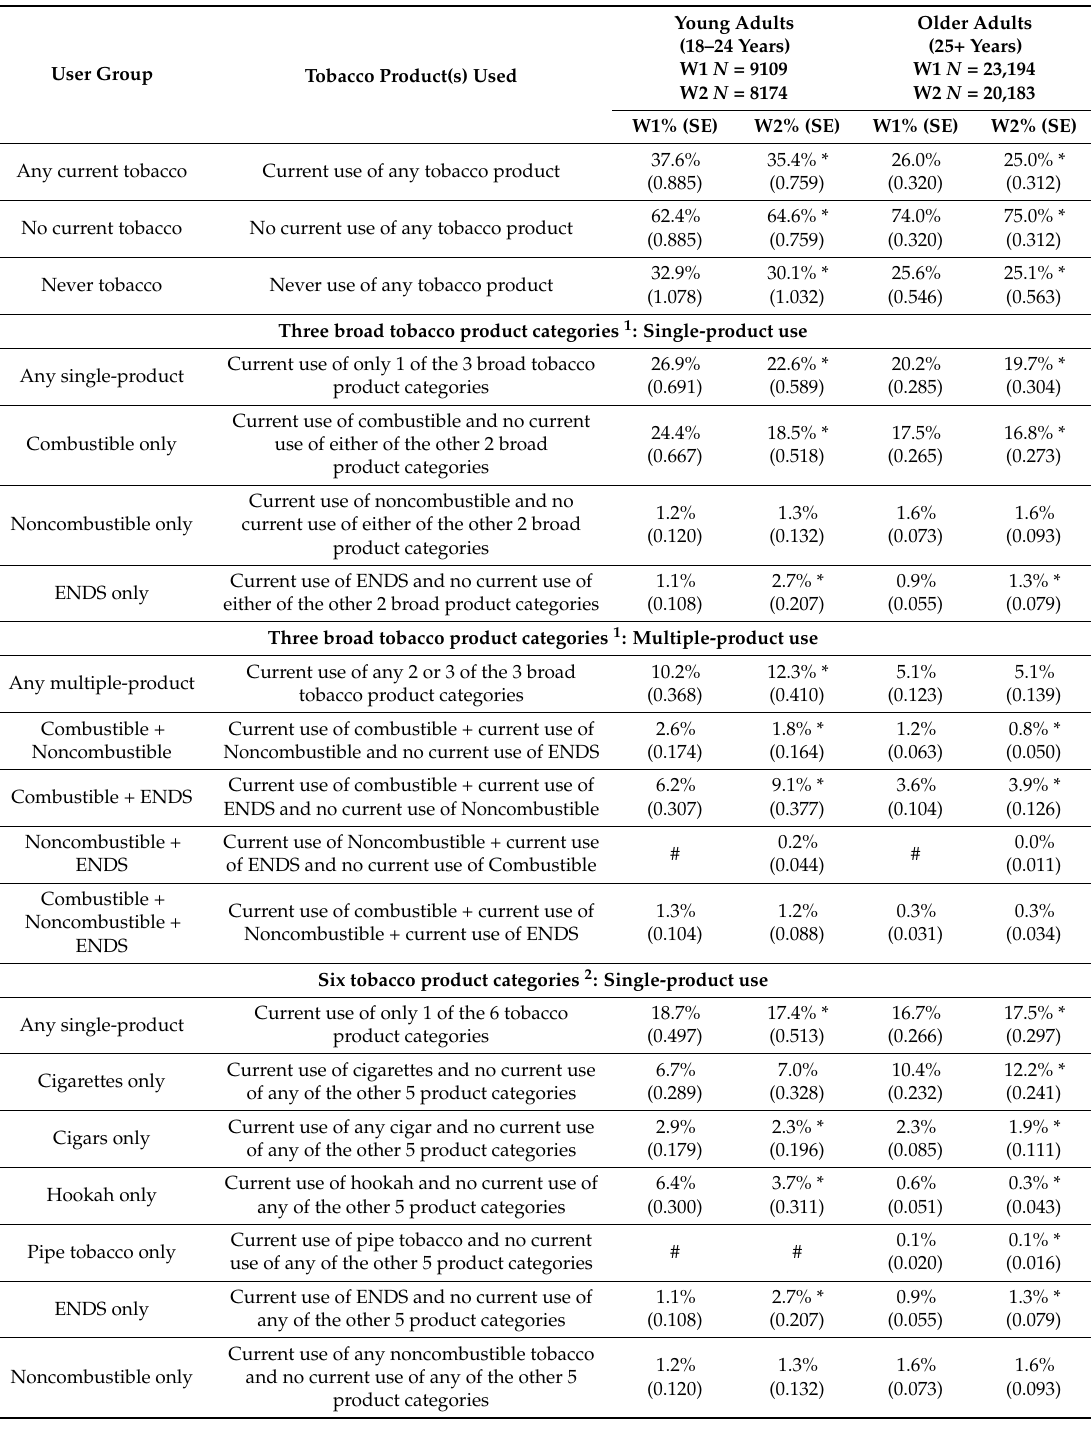
Table 1. Tobacco product user groups and cross-sectional weighted prevalence among adults at Wave 1 and Wave 2 of the Population Assessment of Tobacco and Health (PATH)